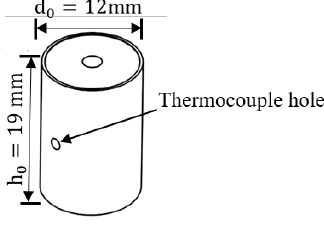
Figure 5. Schematic of the cylinders used in this study for hot compression testing.